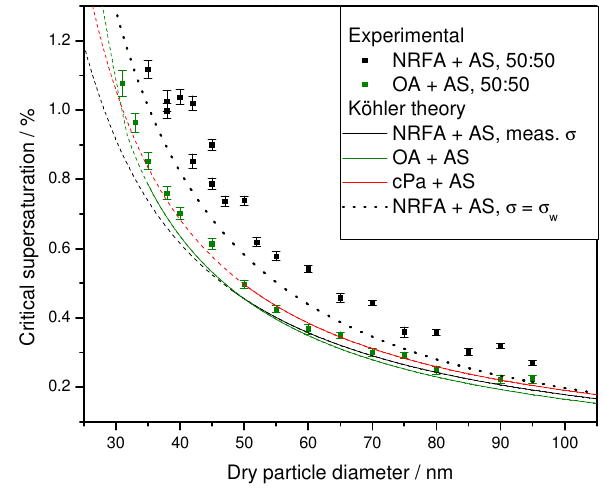
Fig. 7. Comparison between critical supersaturation measured with CCNC and calculated K¨ohler theory based on measured water ac- tivity and the surface tension of water for the four mixtures con- taining oxalic acid (abbreviations are explained in Table 1). The dashed sections indicate that the parameterizations of water activity are based on extrapolation.